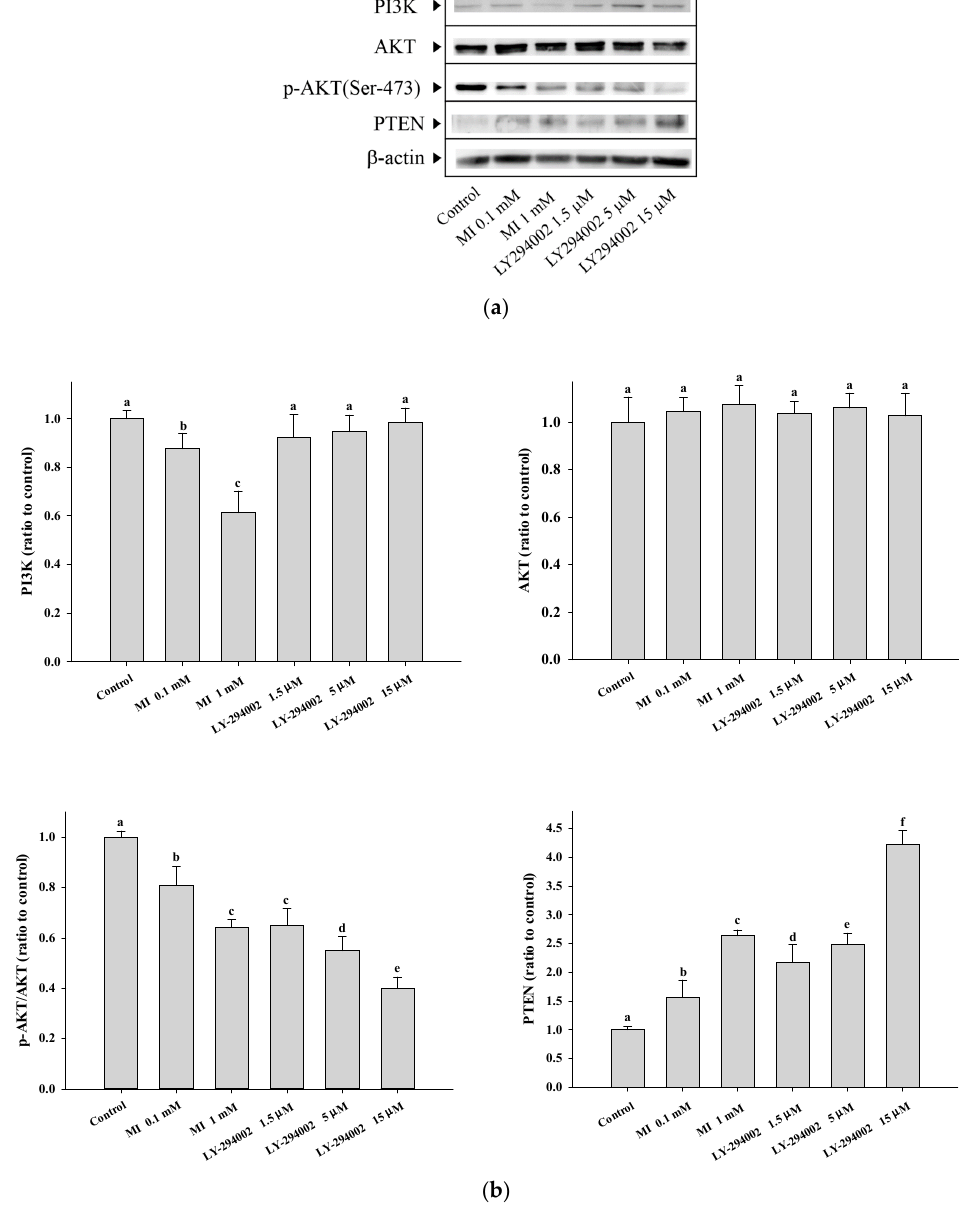
Figure 6. Effects of the myo-inositol (MI) on the expressions of PI3K, AKT, and PTEN, and the phos- phorylation of AKT in Hs68 cells. After being treated with various concentrations of MI and LY294002 for five days, the cell lysates were obtained. The protein expressions or AKT phosphory- lation level in the cell lysates were detected by the Western blot method as described in Methods. ( a ) Western blot Images; ( b ) Western blot quantification results (n = 3 independent experiments). Values (mean ± SD) not sharing a common letter are significantly different ( p < 0.05). As shown in Figure 6a,b, Both MI and LY-294002 increased the expressions of PTEN in a dose-dependent manner.